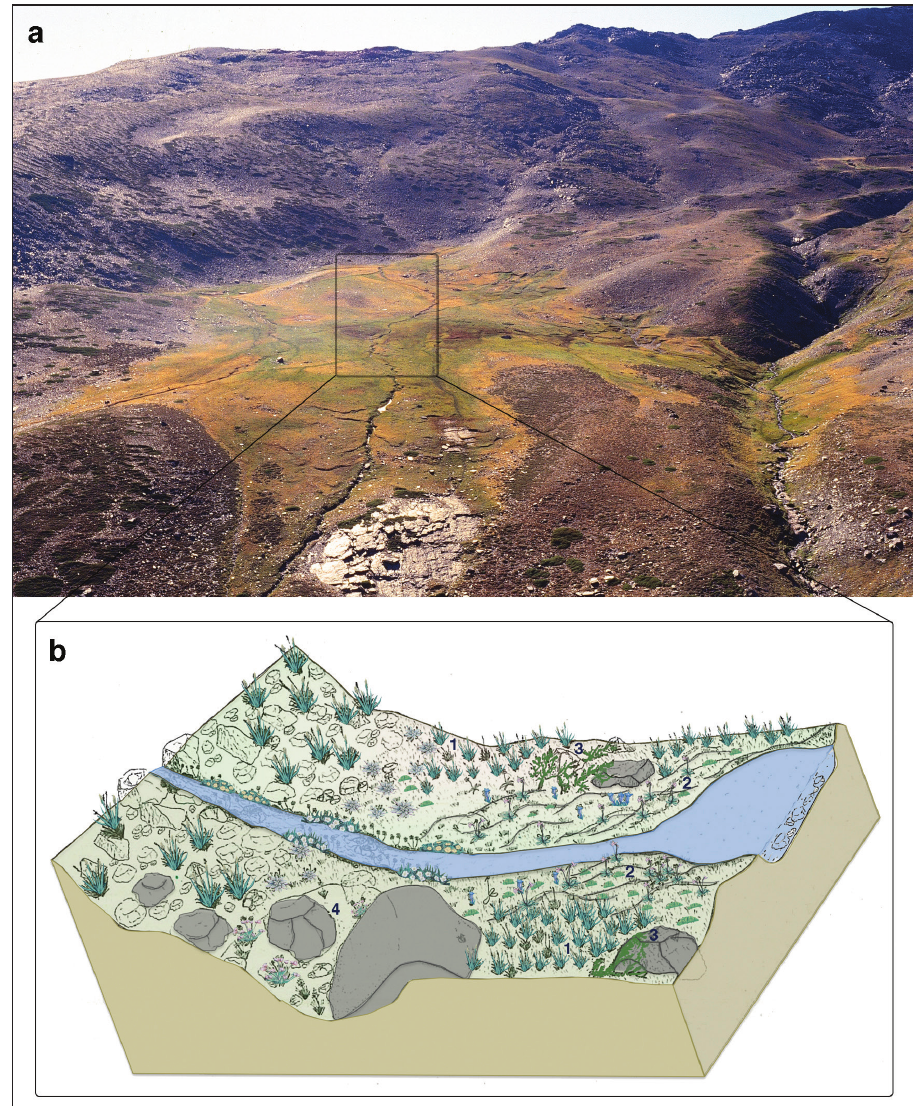
Figure 4. ( a ) Panoramic view of the borreguil of San Juan valley. The particular zonation of this ecosystem depending on soil moisture is reflected in the different colours of the borreguil. ( b ) Schematic representation of the vegetal communities forming the borreguiles, including dry borreguil ( 4 Armerio-Agrostietum nevadensis ), dense grassland ( 1 Nardo-Festucetum ibericae ), incipient peat formations ( 2 Ranunculo-Caricetum intrincatae ) and variants of borreguil in promontory areas ( 3 Ranunculo-Vaccinietum uliginosi ). Modified from Losa-Quintana et al. (1986). Picture: JM